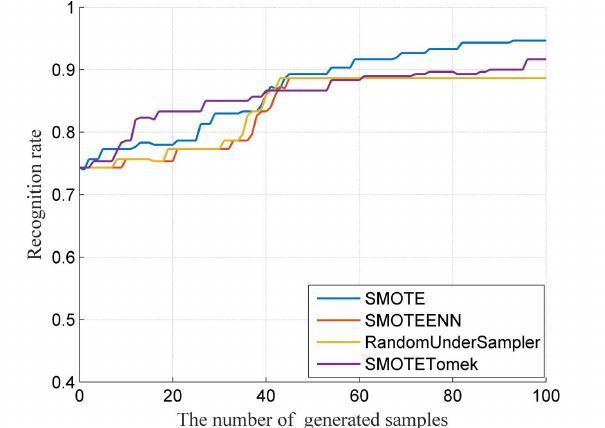
Figure 15. The recognition rate of different generation algorithms. Table 1. Comparison of recognition results of different